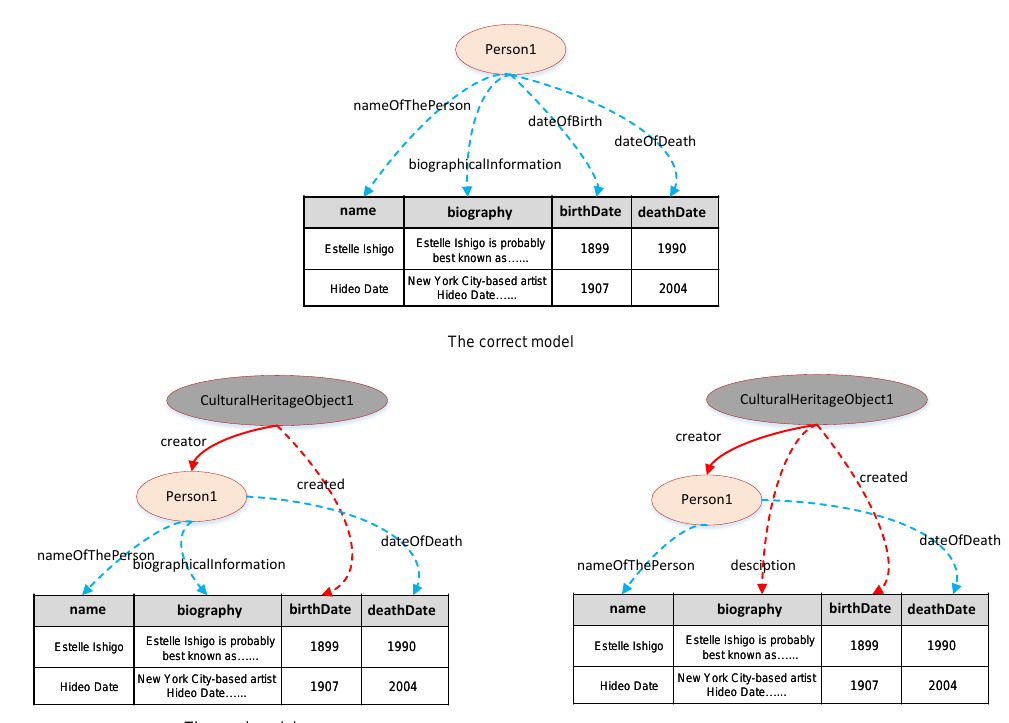
Figure 6. The predict result of s 9 in ds edm , using s 2 and s 6 as training sets.